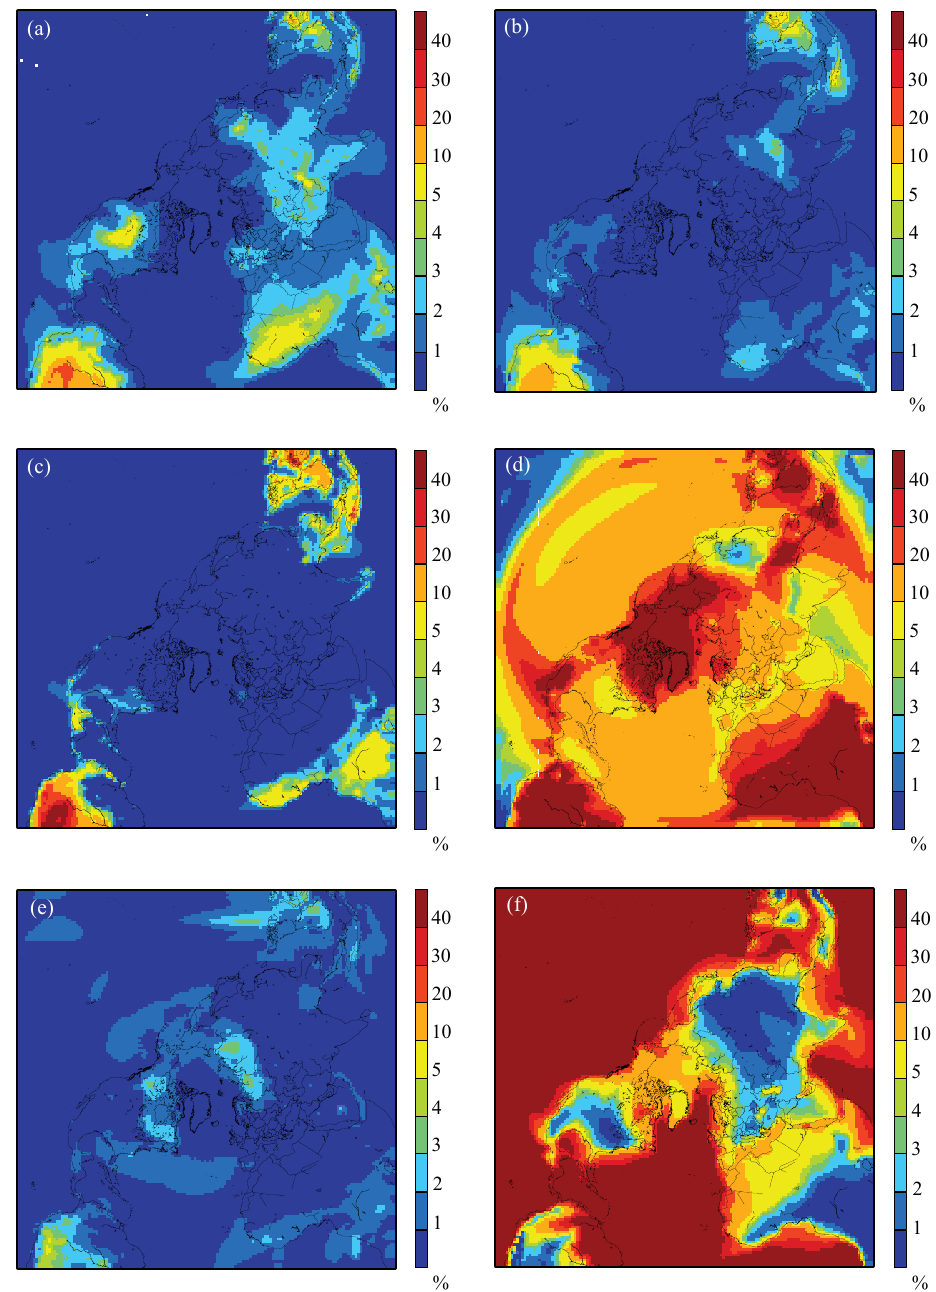
Fig. 14. Relative contributions (%) of the natural sources to annual average PM 2 . 5 concentrations in 2006. The impacts of natural emissions of (a) SNO x (NO x from soils), (b) LNO x (NO x from lightning), (c) biogenic VOCs, emissions (d) from wildfires, (f) natural NH 3 , and (e) sea salt on PM 2 . 5 levels are shown.